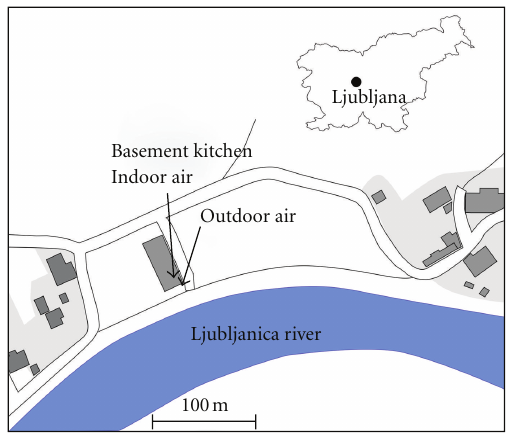
Figure 1: Layout of the measurement